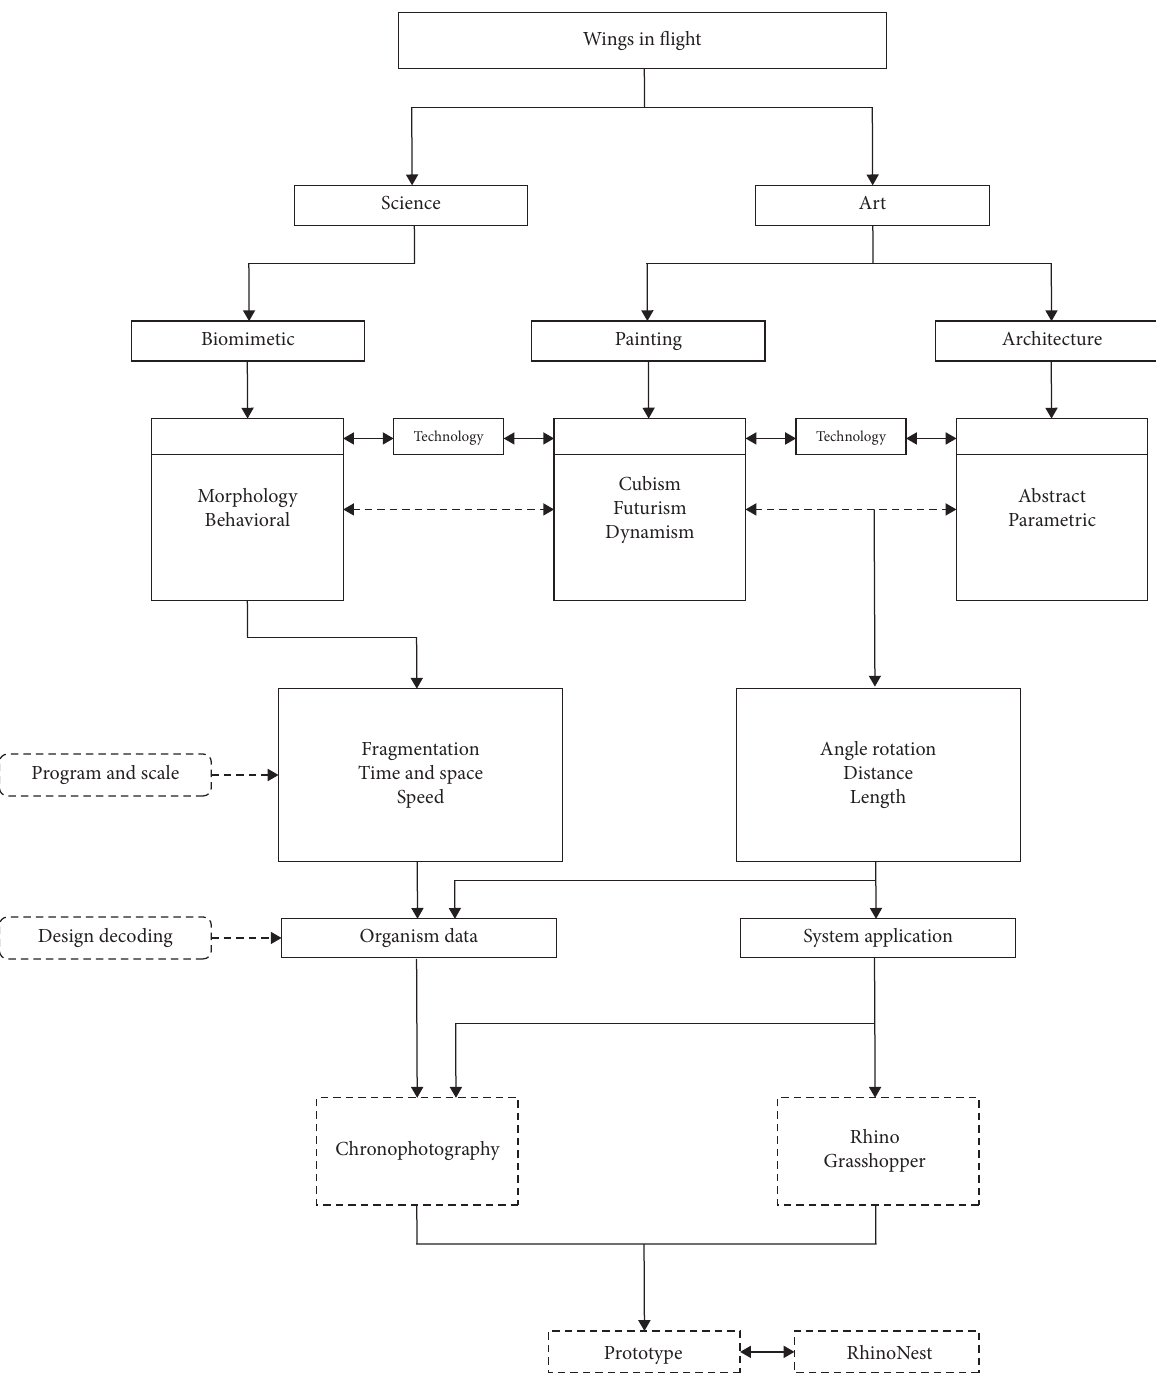
Figure 1: Diagram relationship between science and art (source: drawing by the research